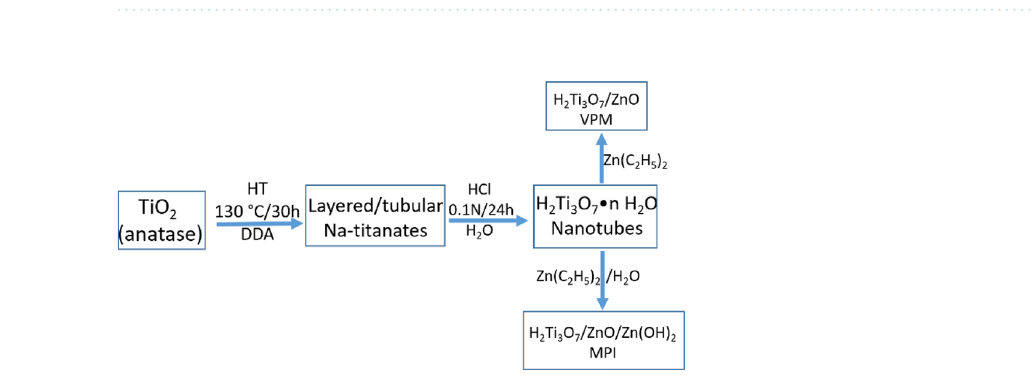
Figure 13. Scheme for the hydrothermal synthesis of titanium oxide nanotubes and their functionalization using VPM and MPI